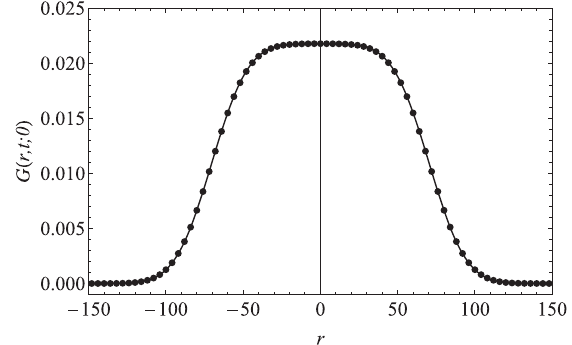
FIG. 15. Continuous line line shows radial cross section (along the line y ¼ 0 ) through numerical solution of the modified OJK equation (21) with population distribution Eq. (20) at time t ¼ 700 , with initial condition r 0 ¼ ð 0 ; 0 Þ . Here, ffiffiffiffiffiffiffiffiffiffiffiffiffiffiffi p r ¼ x 2 þ y 2 ¼ x . Parameter values are βσ 2 ¼ 1 and R ¼ 10 . Data points show asymptotic analytical solution G ðj r j ; t ; 0 Þ [Eq. (30)], with t ¼ 700 , time offset t 0 ¼ − 4 . 4 , and A ¼ 0 . 0109 (found by maximum